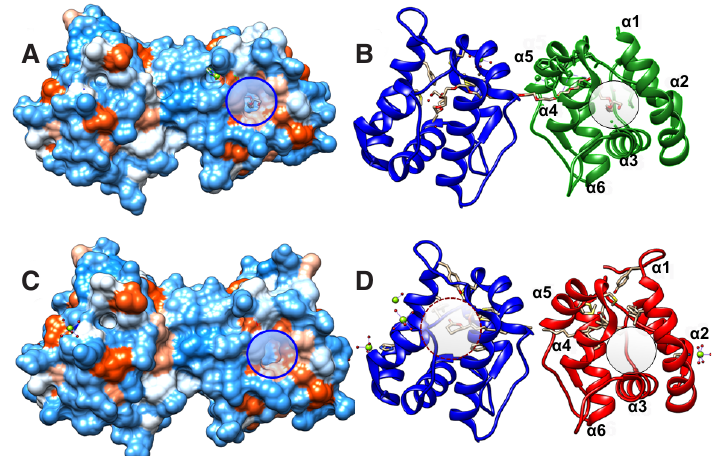
Figure 7. Structures of AaegOBP1 and CquiOBP1 bound to PEG and MOP, respectively. ( A and C ) Hydrophobicity surfaces of AaegOBP1 and CquiOBP1. ( B and D ) Ribbon displays of the same structures. A potential secondary binding site for MOP is highlighted with circles. It is occupied by PEG in AaegOBP1 but “empty” in CquiOBP1. The central cavity is highlighted in ( D ) with a dashed circle and shows that only the polar head (lactone moiety) of MOP is housed in the core of the protein. Figure prepared with UCSF Chimera